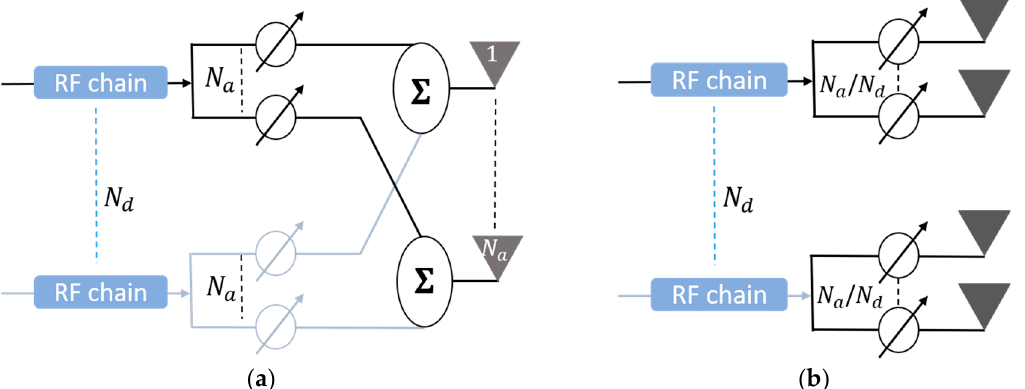
Figure 1. Hybrid beamforming.